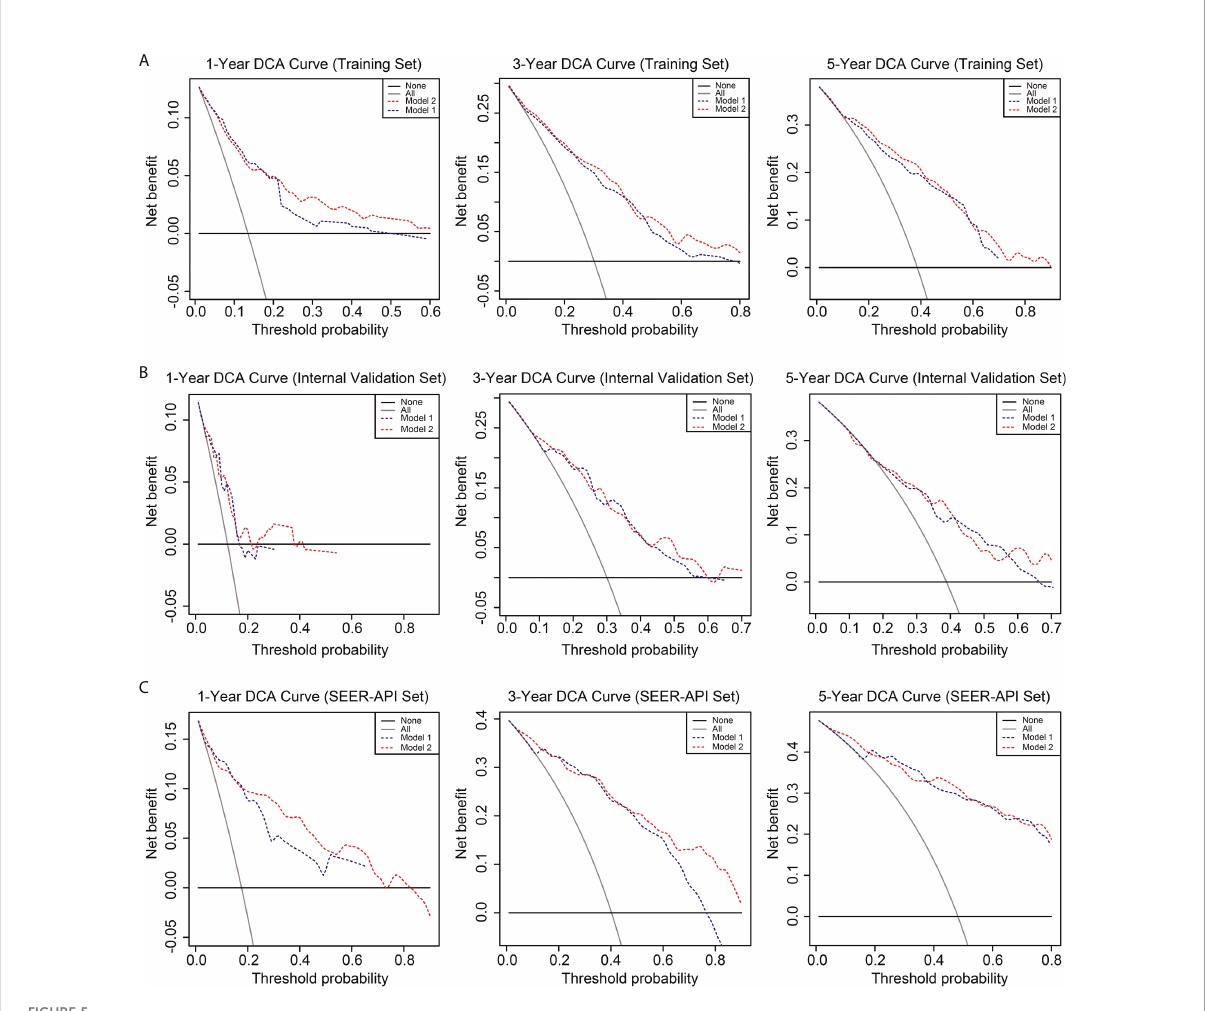
FIGURE 5 Decision curve analysis (DCA) of the two nomograms. The DCA curves of two nomograms in the training set (A) , internal validation set (B) , and SEER-API external validation set (C) were plotted based on 1-, 3-, and 5-year CSS, respectively. The blue line represents model 1, and the red line represents model